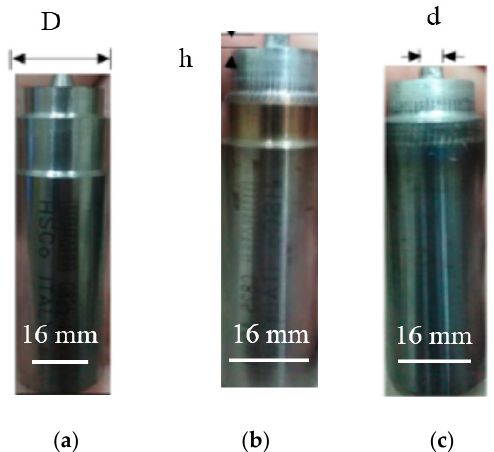
Figure 1. Tool geometries employed in the present study: ( a ) HSCo tapered tool; ( b ) HSCo squared tool; and ( c ) WC squared tool.